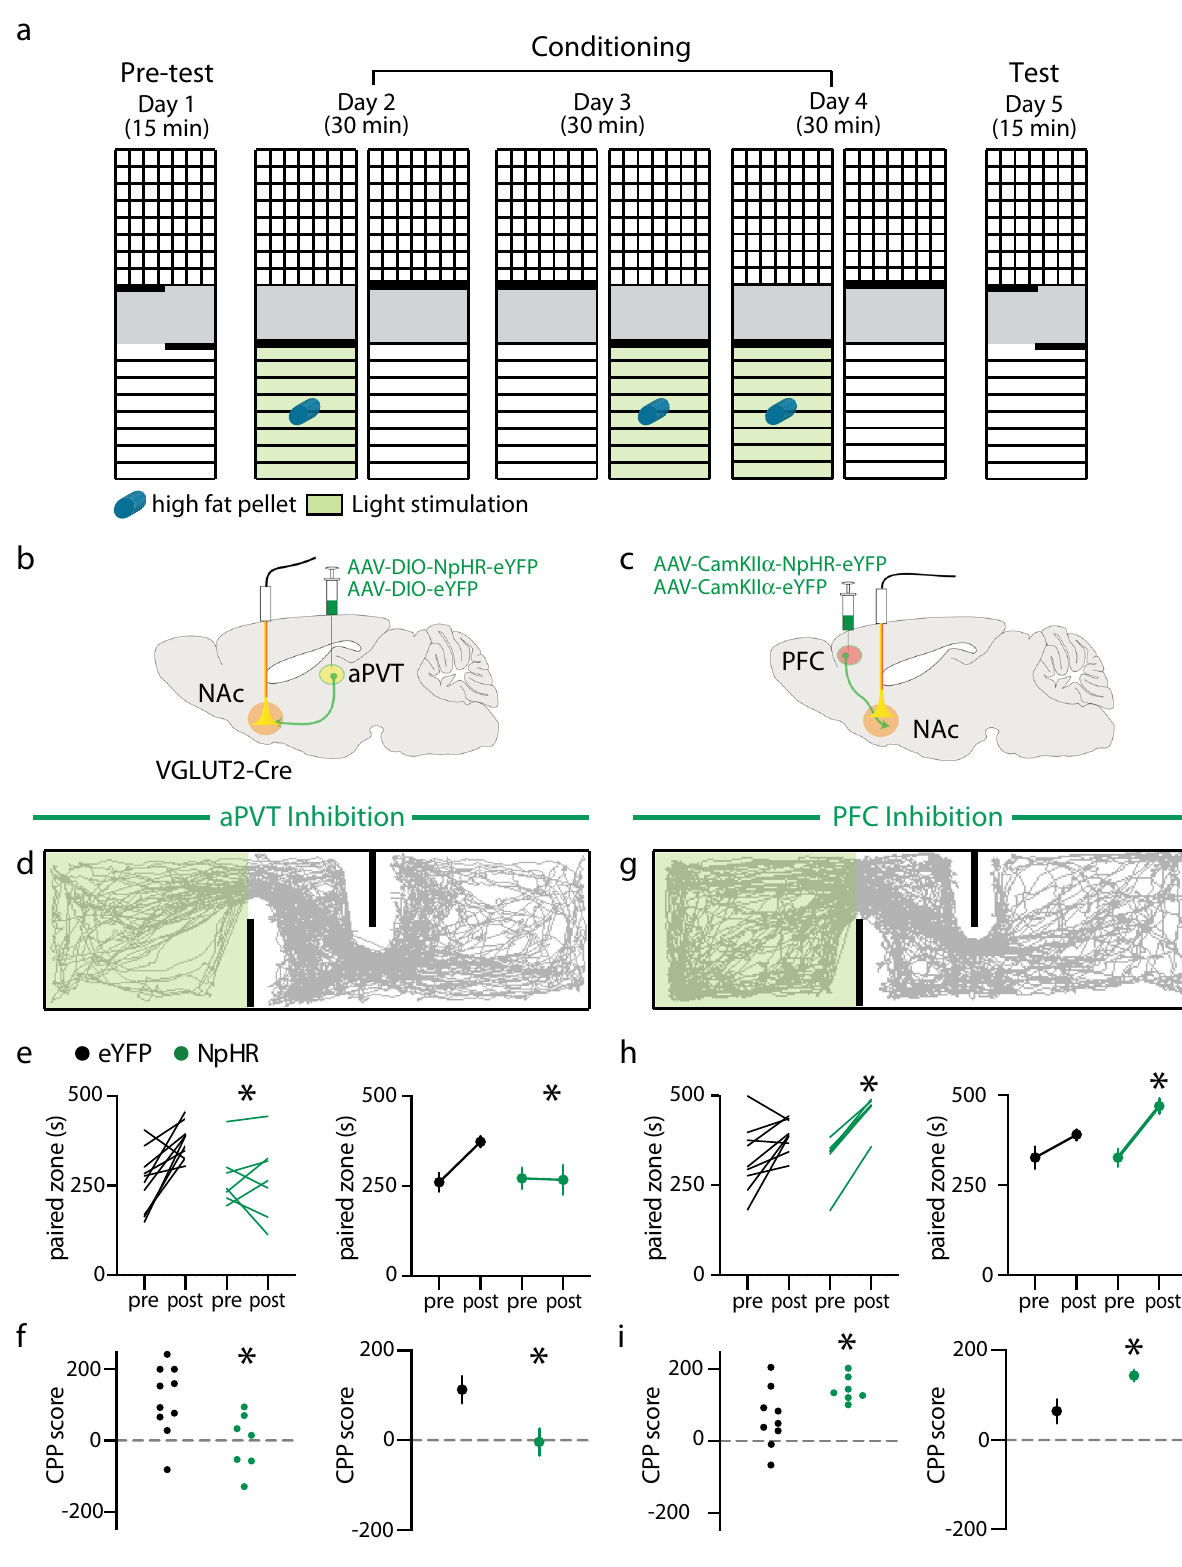
preparing acute brain slices from which AMPAR/NMDAR ratios were measured. This protocol reduced the AMPAR/NMDAR ratios at aPVT → D1 MSN synapses (Fig. 6d), thereby con fi rming the ef fi cacy of the optogenetic stimulation in reducing synaptic strength. To mimic the depression in strength at PFC → D2